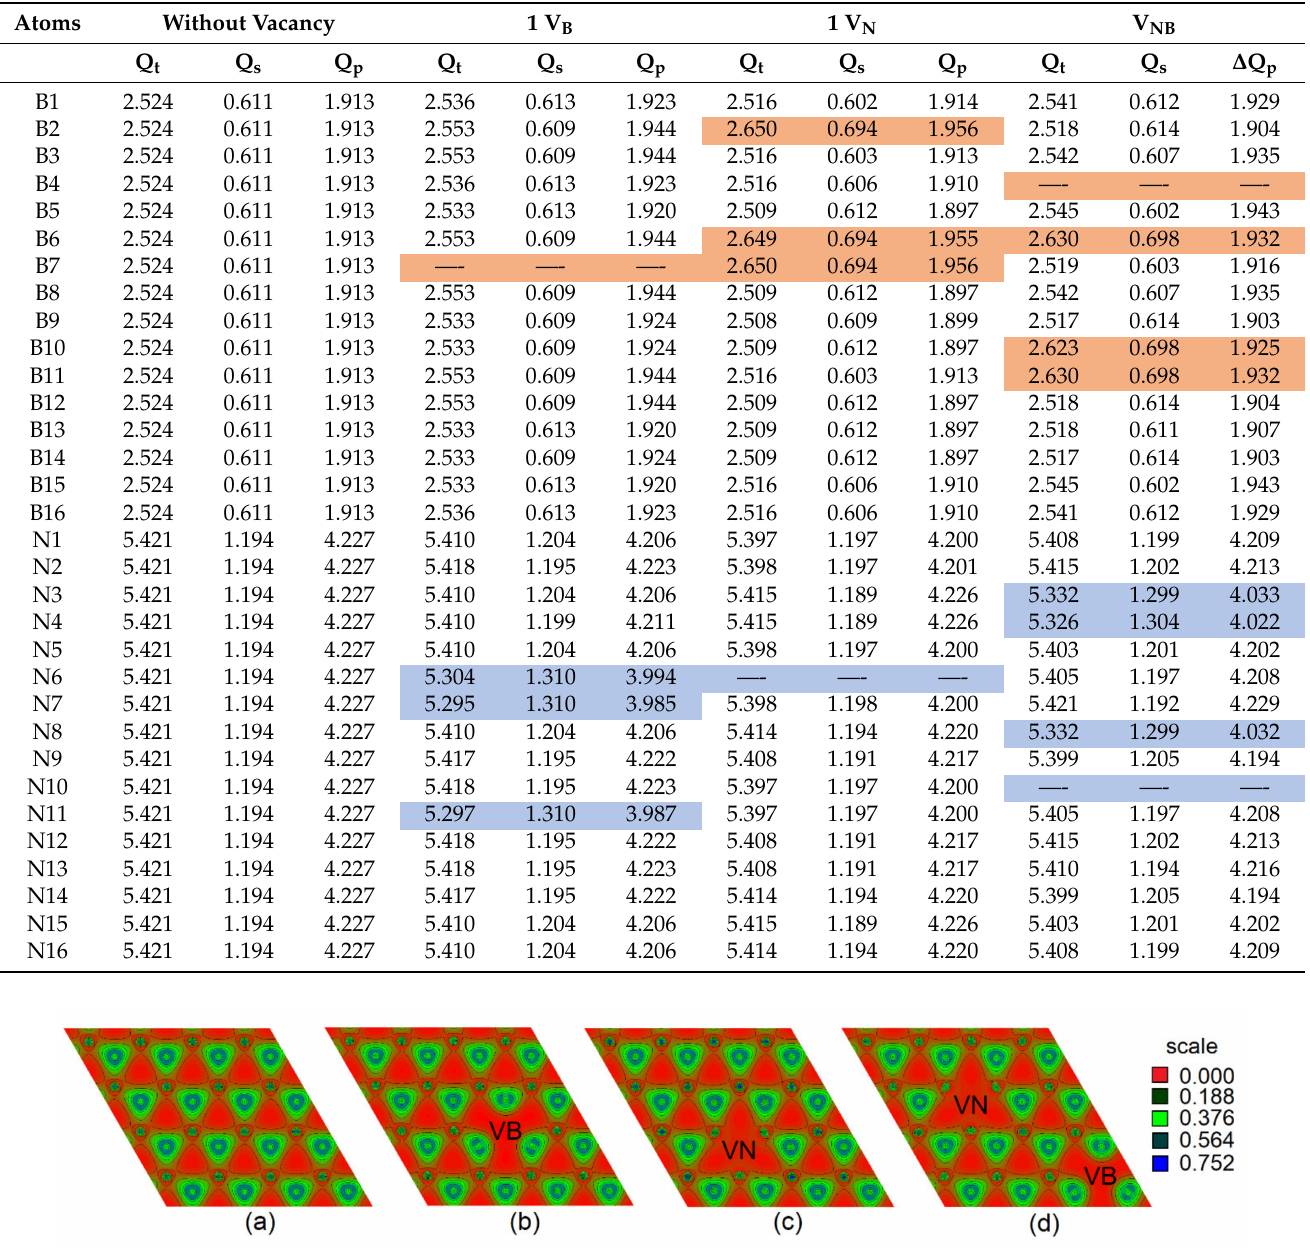
Figure 5. Contour maps of the electronic density of the heterobilayer ( a ) without vacancy, ( b ) 1 V B , ( c ) 1 V N , and ( d ) co-vacancy V BN ,